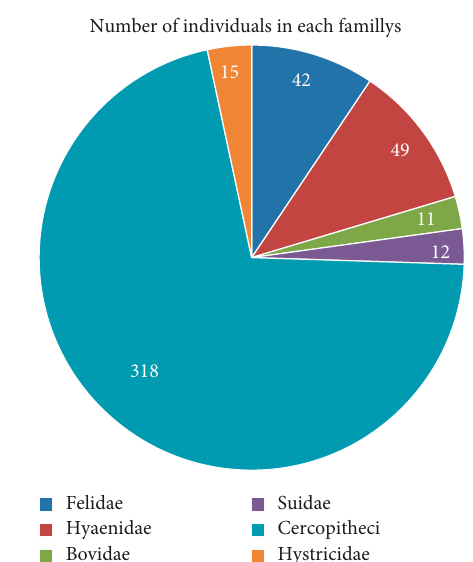
Figure 3: Number of individuals in each